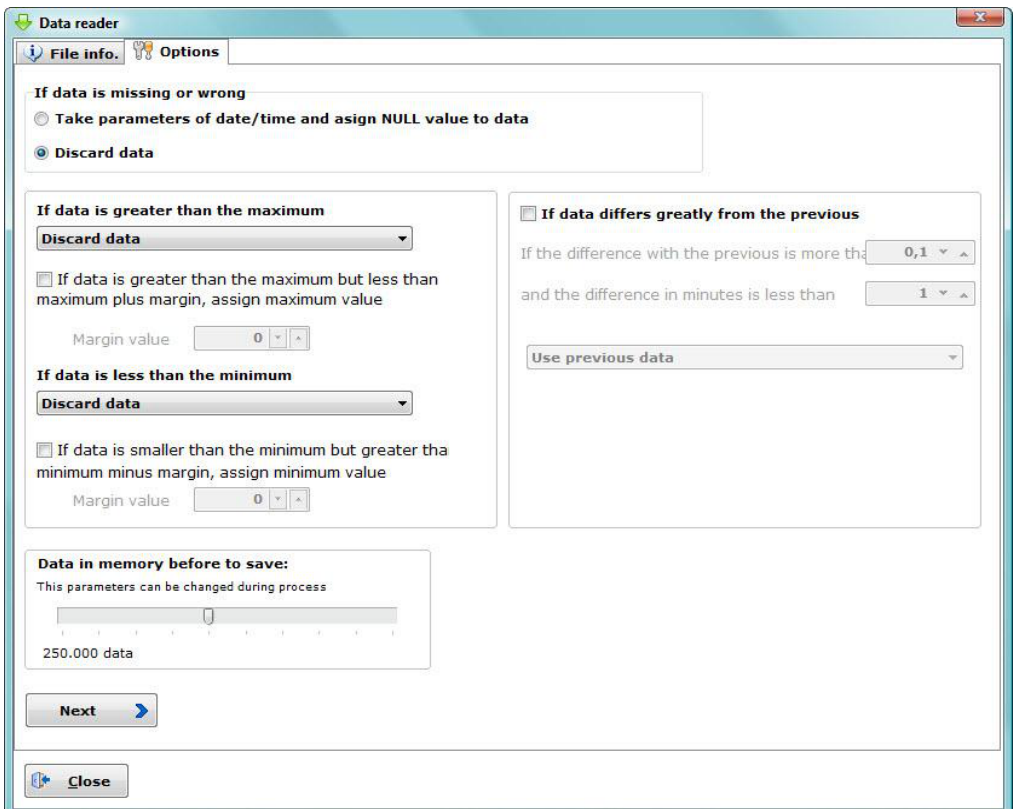
Figure 5. Data reader